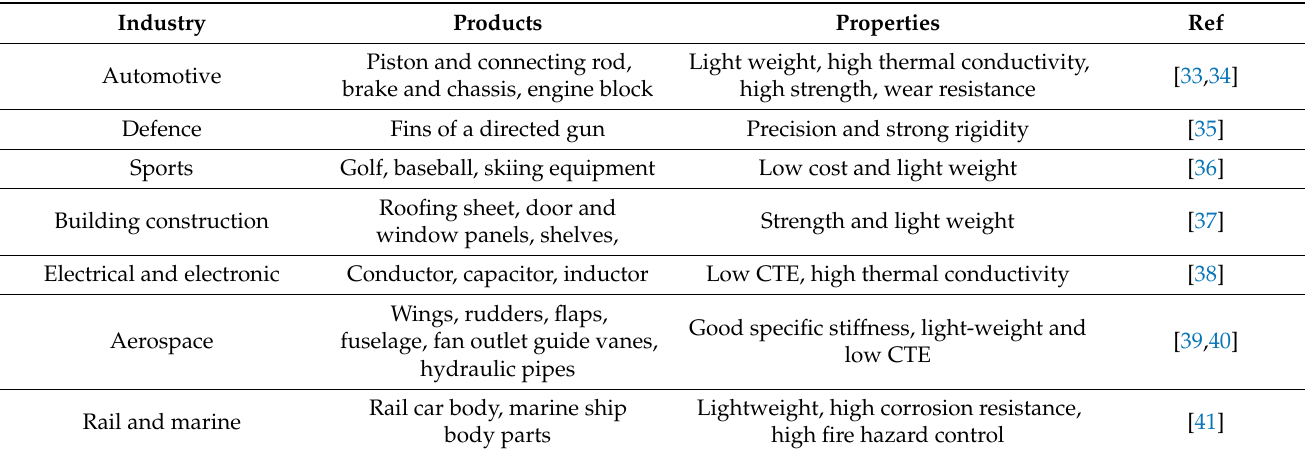
Table 1. Components/products developed from